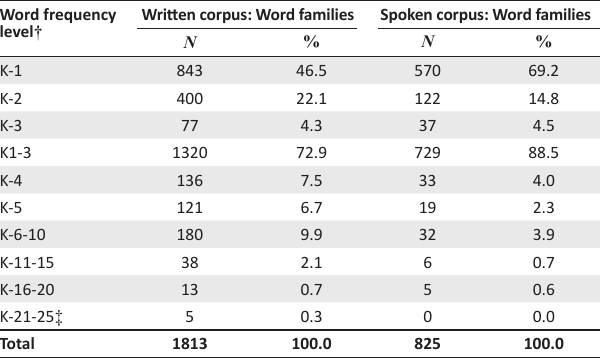
TABLE 3: Number of words per word frequency level in written and spoken